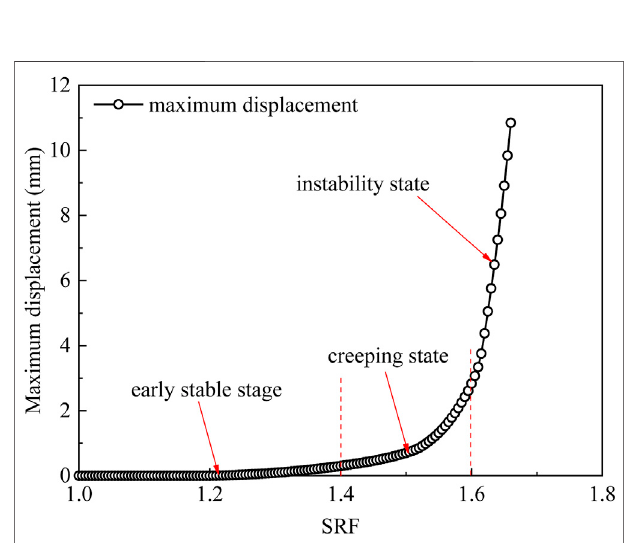
FIGURE 10 | Evolution curves of maximum porosity and maximum permeability.